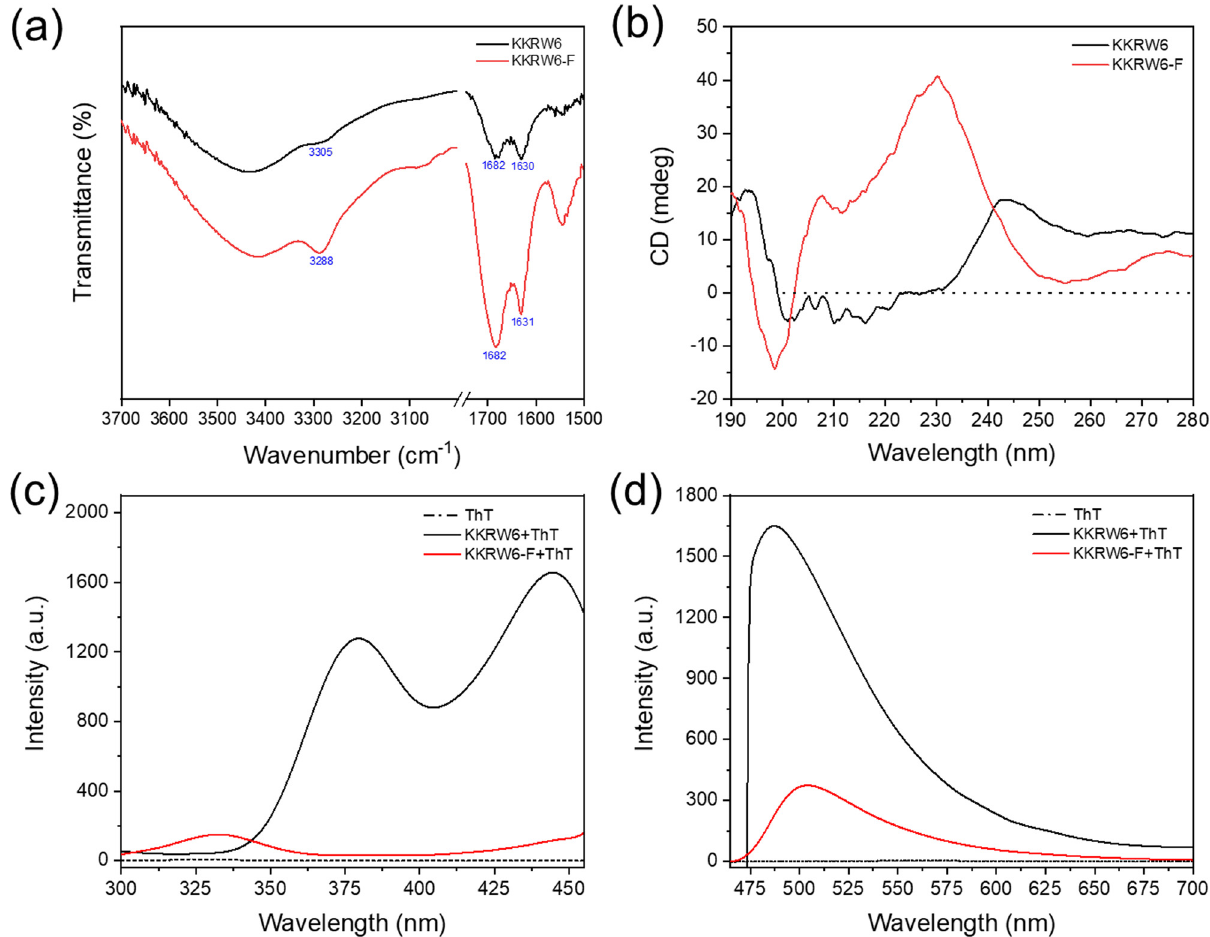
Figure 5: ( a ) FTIR and ( b ) CD spectra of KKWR6 and KKWR6 - F peptide self - assemblies; ( c ) fl uorescence excitation spectra and ( d ) fl uor - escence emission of ThT solution ( 1 mg · mL − 1 ) and KKWR6 and KKWR6 - F peptide self - assemblies dyed with ThT with λ em = 482 nm and λ = 450 nm, ex